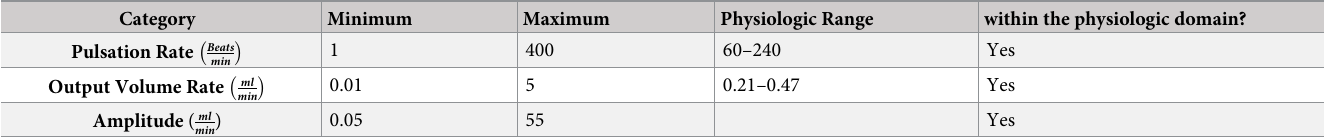
Table 1. Pump optimal domain and relative to the human physiologic range.